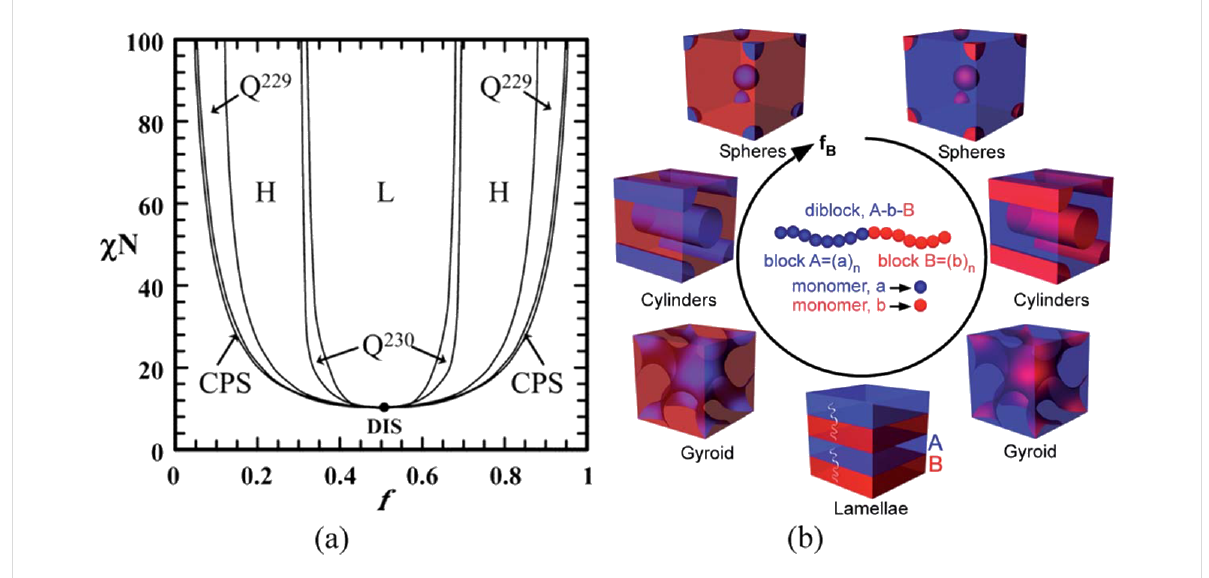
Figure 1: a) Phase diagram of diblock copolymer predicted by SCMF theory. Reprinted with permission from [41], copyright 2006 American Chemical Society. b) Various microdomain organization patterns of a linear AB diblock copolymers. Reprinted with permission from [42], copyright 2014 The Royal Society of Chemistry. f : volume fraction of one block; χ : Flory–Huggins interaction parameter; N: degree of polymerization; L: lamellae; H: hexagonally packed cylinders; Q 230 : double-gyroid phase; Q 229 : body centered spheres; CPS: closed-packed spheres; and DIS: